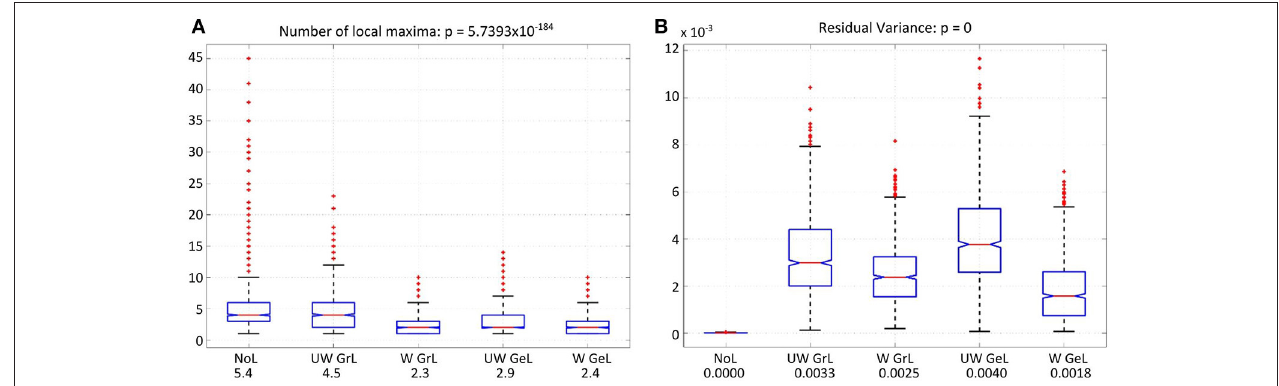
FIGURE 9 | Number of local maxima (A) and residual variance (B) for LORETA with the different operator types. The red lines on each box mark the median, the blue boxes denote the 25th and 75th percentiles, the dashed lines extend to the most extreme data points not considering outliers; red crosses denote the outliers. (A) Number of local maxima for all four Laplace operators and minimum-norm (without Laplacian, left-most). The values beside the captions on the x-axis are the mean number of local maxima. (B) Residual variance for all solutions with and without Laplace operator. The solution without Laplace (left-most) yielded the lowest residual value. The values beside the captions on the x-axis are the corresponding mean residual variances.